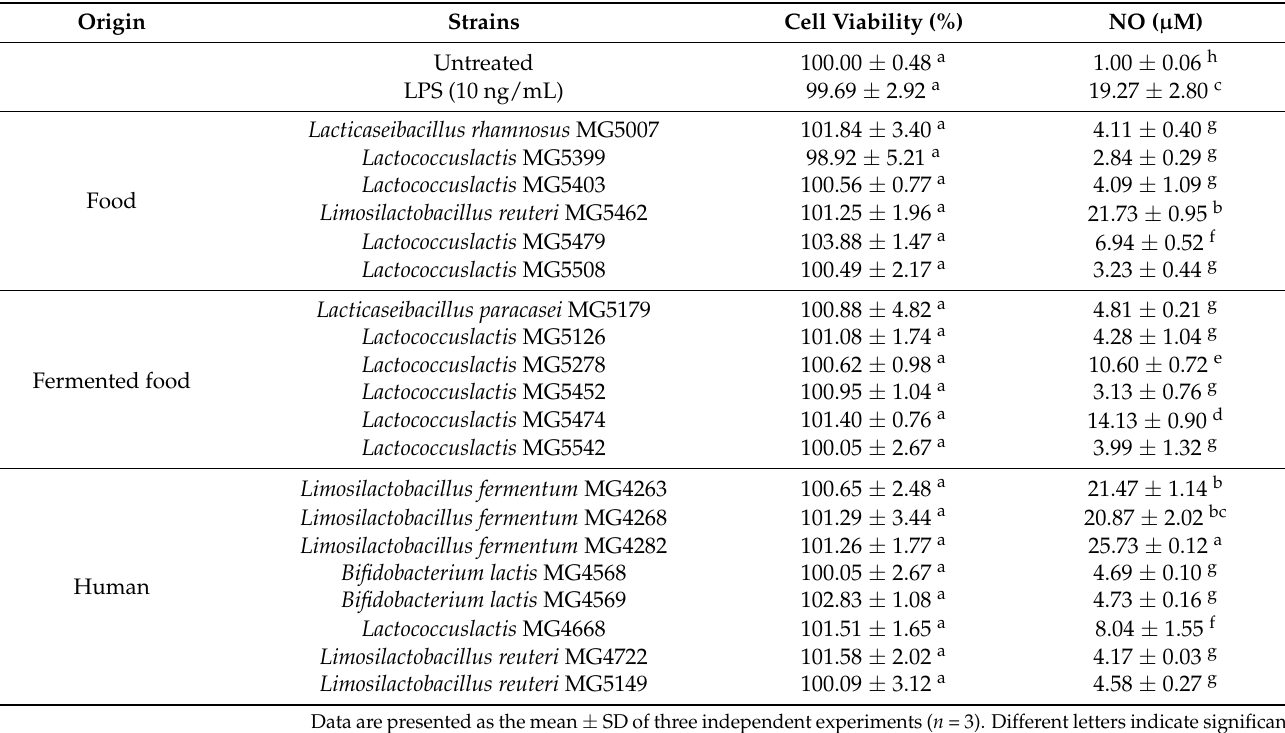
Table 1. Effect of CFS from LAB strains on cell viability and NO production in RAW264.7